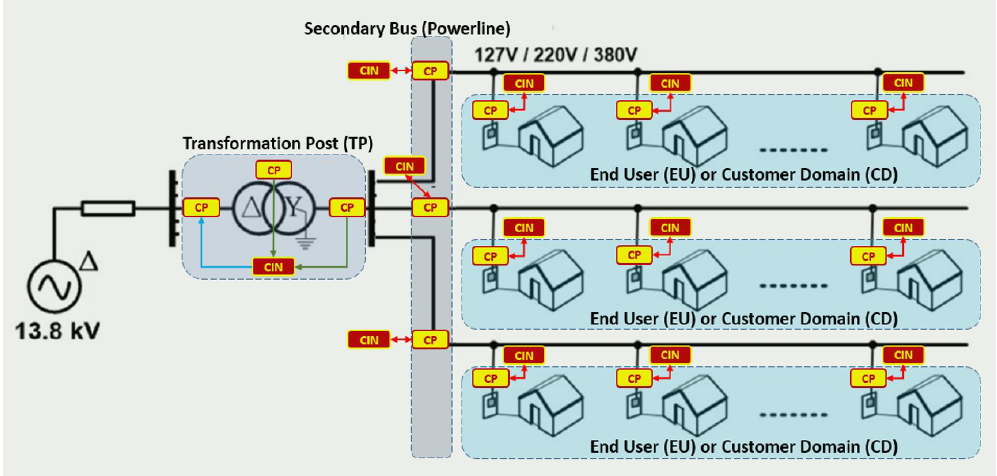
Figure 5. Set of DRF Servers, made available by the Middleware Layer and distributed among the LV circuit